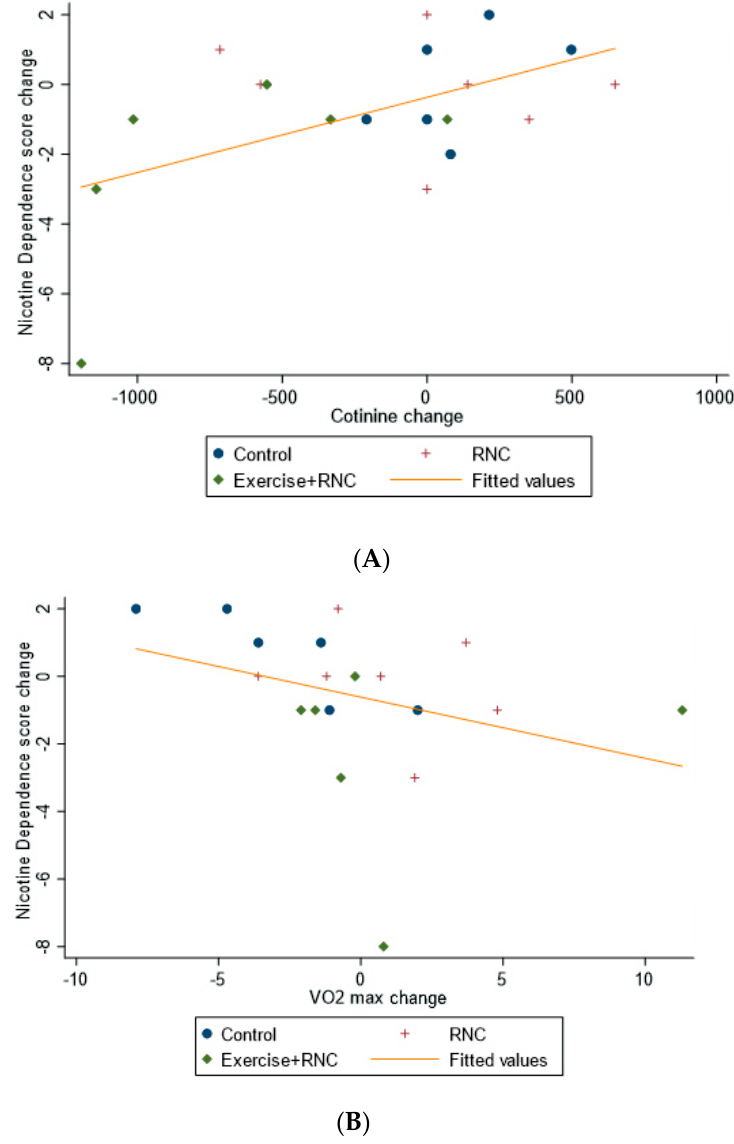
Figure 1. ( A ). Pearson correlation between nicotine dependence score change and cotinine change. Note: r = 0.52 ( p = 0.02). ( B ). Spearman ranked correlation between nicotine dependence score change and VO 2 max change. Note: r = − 0.50 ( p = 0.03).